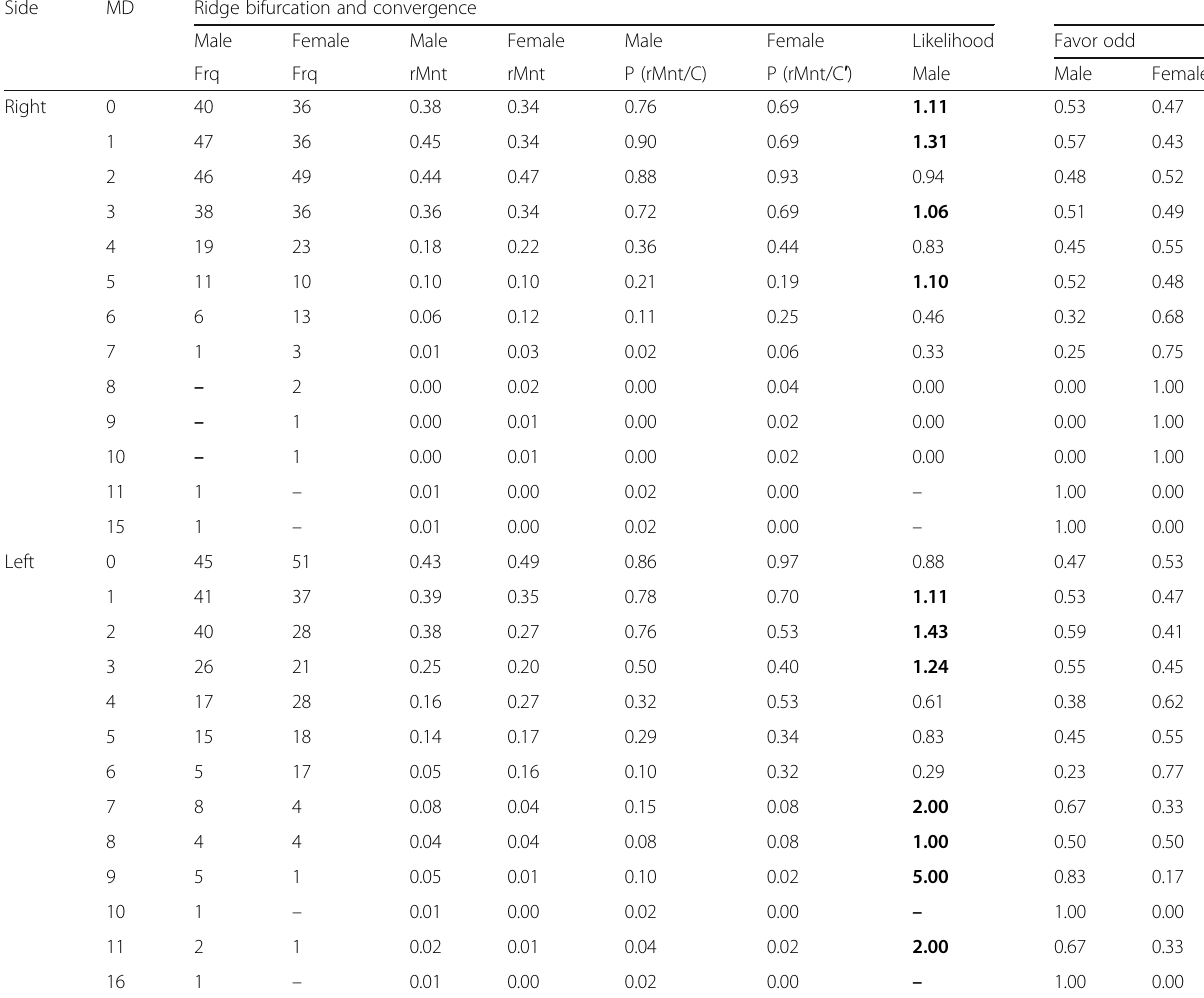
Table 1 Frequency, likelihood ratio and favor odd of different ridge bifurcation and convergent density of right and left thumbprints Side MD Ridge bifurcation and convergence